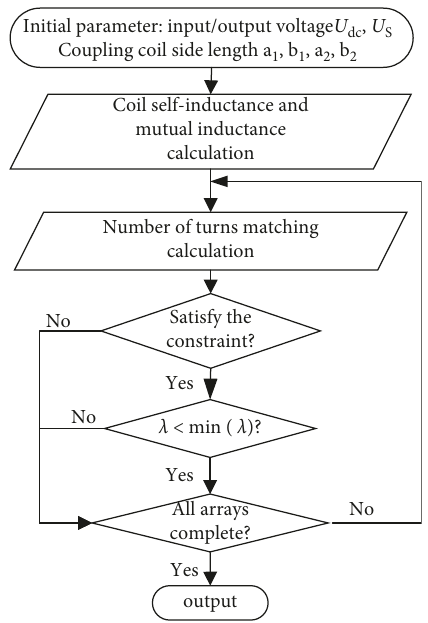
Figure 9: Flow chart of coil parameter design.